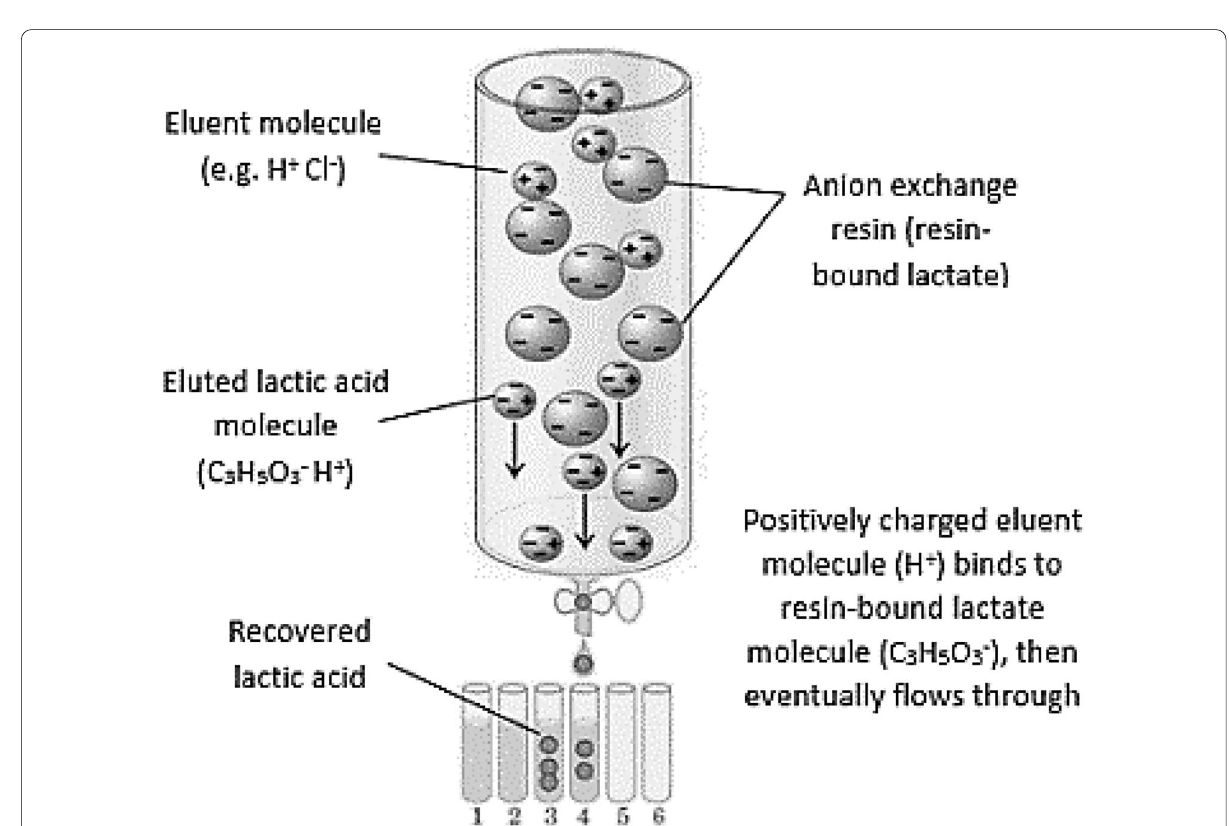
Fig. 5 Liquid adsorption/elution process to recover lactic acid. Modified with permission from Bio-Resource (Bio-Resource